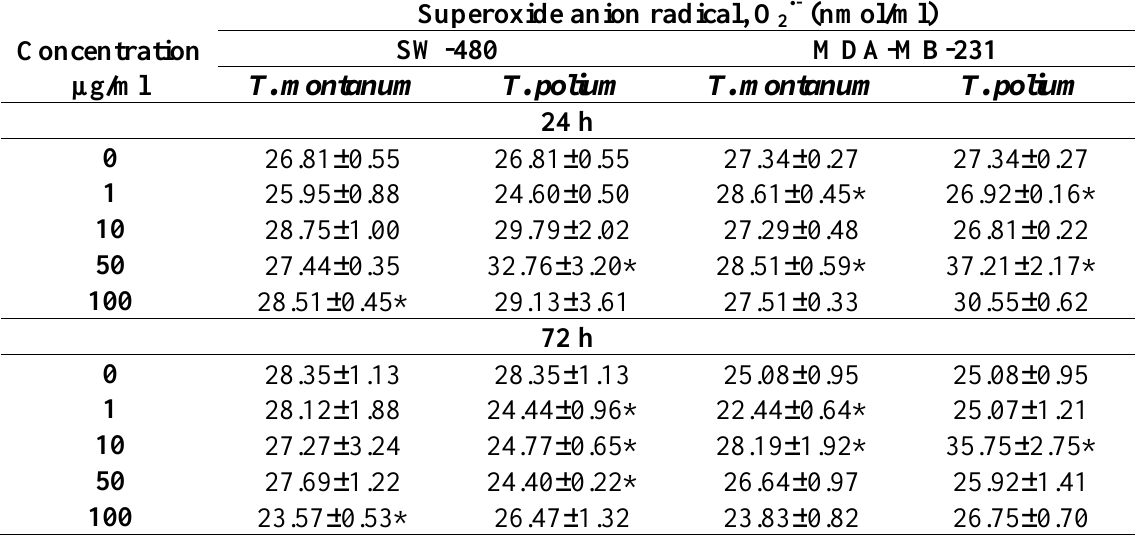
Table 1. Effects of methanolic extracts of Teucrium montanum and T. polium on SW-480 and MDA-MB-231 cell lines, expressed as the O 2•– concentration after 24 h and 72 h of exposure. *p < 0.05 as compared to the control